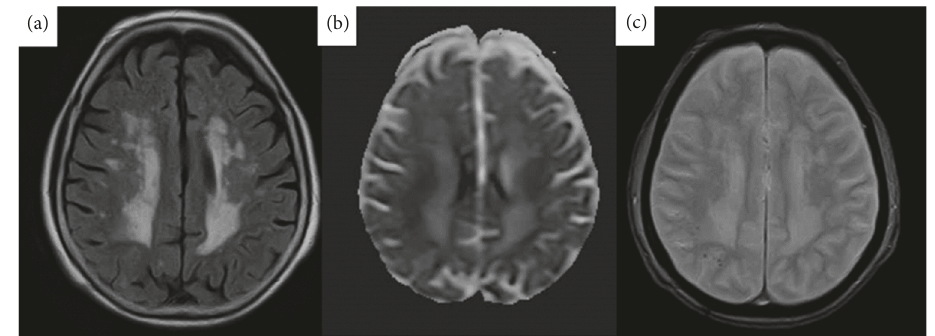
Figure 2: A follow-up brain magnetic resonance imaging (MRI) performed after 4 months shows a reduction of hyperintensity on fluid- attenuated inversion recovery (FLAIR; (a)) and apparent diffusion coefficient (ADC; (b)) in the right parietal lobe. The reduced subcortical microbleeds in the right parietal lobe are noted